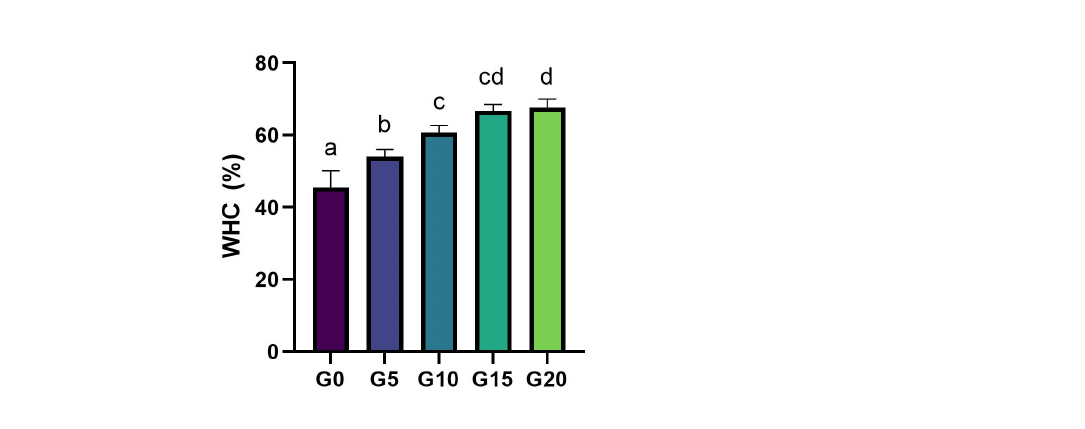
Figure 8. Water-holding capacity (WHC) of fermented PPI gels after 7 days of storage under refriger- ation at 5 °C. Sample name corresponds to its oil content, e.g., G0: 0% oil, G5: 5% oil, etc. Significant differences between samples were highlighted by different letters.